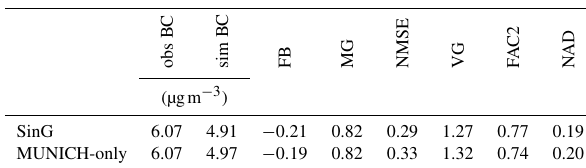
Table A1. Comparisons to BC measurements in Boulevard Alsace Lorraine: statistical indicators obtained with SinG and MUNICH- only